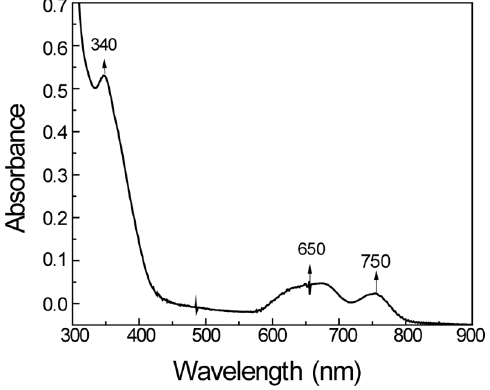
Figure 3. Absorption spectra of PyAeADHII Co-complex. The lack of a weak band at 520 nm and the presence of the 740 nm band indicates that cobalt was substituted at the structural site.